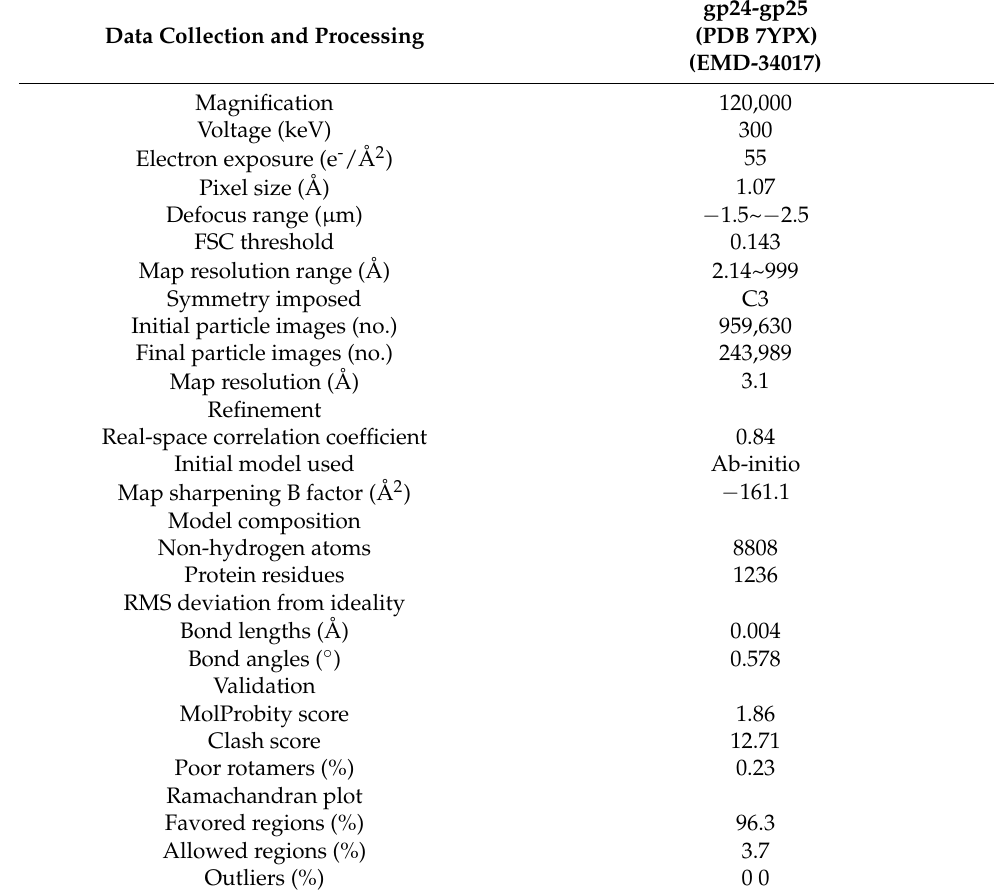
Table 1. Cryo-EM parameters, data collection and refinement